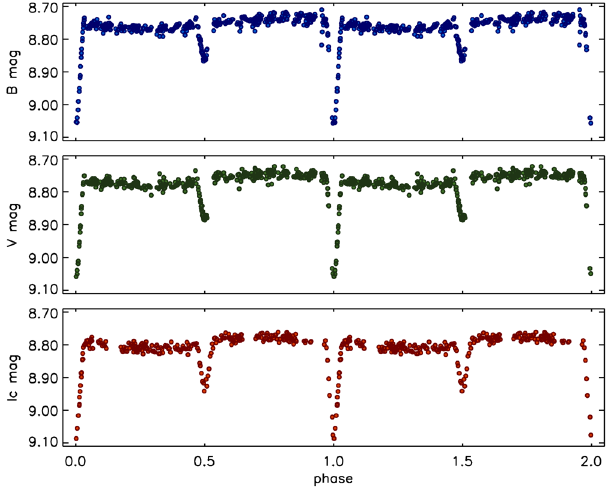
Figure 1. Phase plots of HD 66051, based on our own photometric observations. The panels indicate, from top to bottom, B , V , and I C data, respectively. Data have been binned (bin-size: 0.02 d). The secondary variability is clearly visible in all